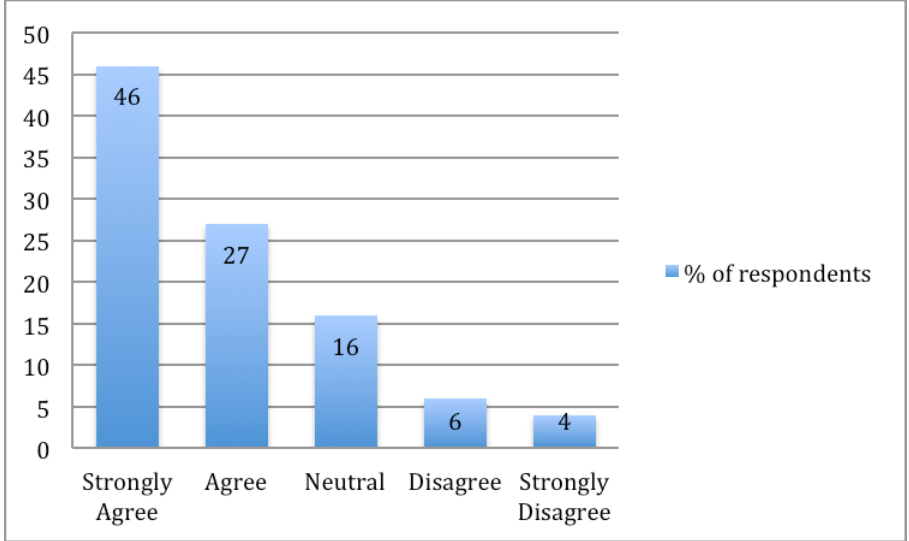
Figure 1 . Low Internet